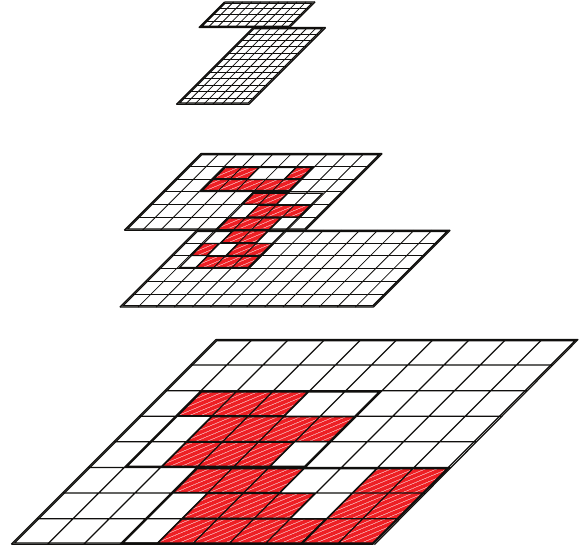
Figure 7: Structured AMR employs a hierarchy of successively embedded rectangular